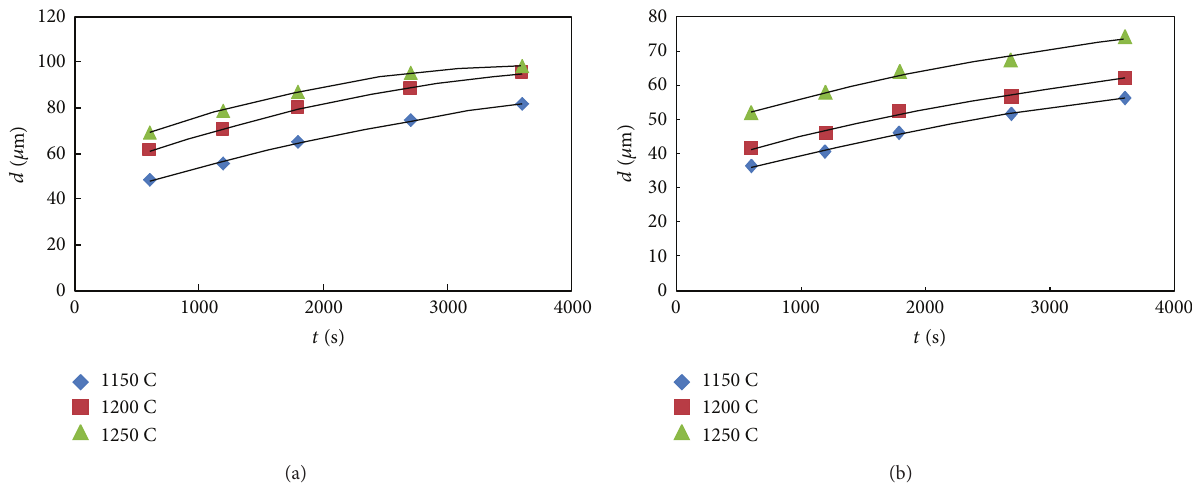
Figure 3: Grain size ( 𝑑 , 𝜇 m) versus holding time ( 𝑡 , sec) plot of (a) X65 grade and (b) X70 grade.